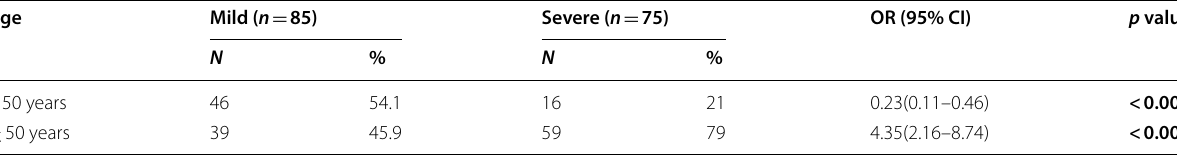
Statistically signficant values are shown in bold N number, % percentage Significant association ( p < 0.05)